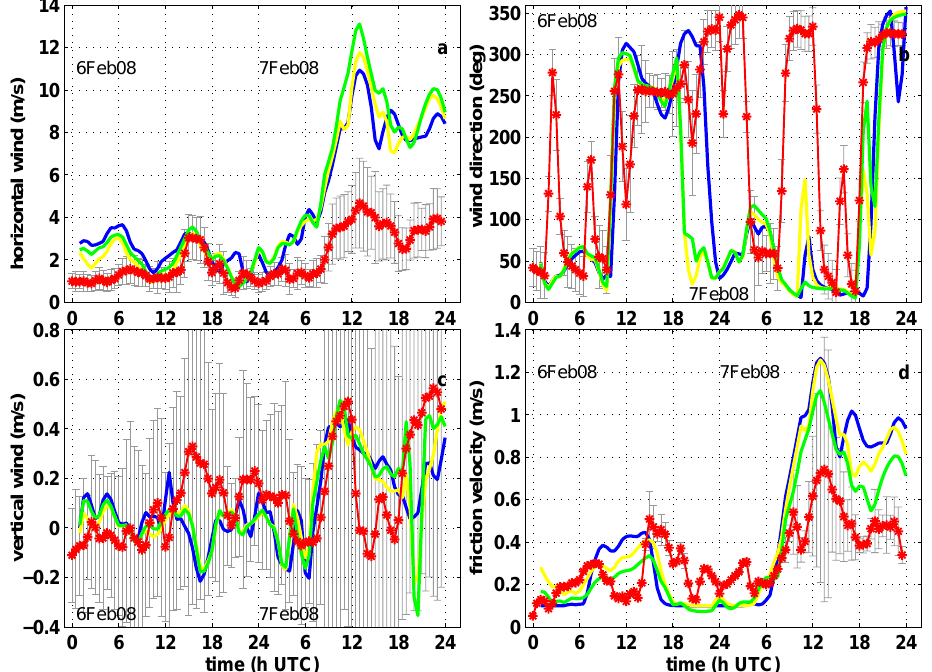
Fig. 3. Time series of horizontal wind speed (a) , and direction (b) , vertical wind (note: model result are multiplied by a factor of 10) (c) , friction velocity (d) for 6–7 February 2008. Color code: YSUtd is blue; YSUNoahNOURB is yellow; YSUNoahUCM1 is green; anemometer measurements are red; and errors are